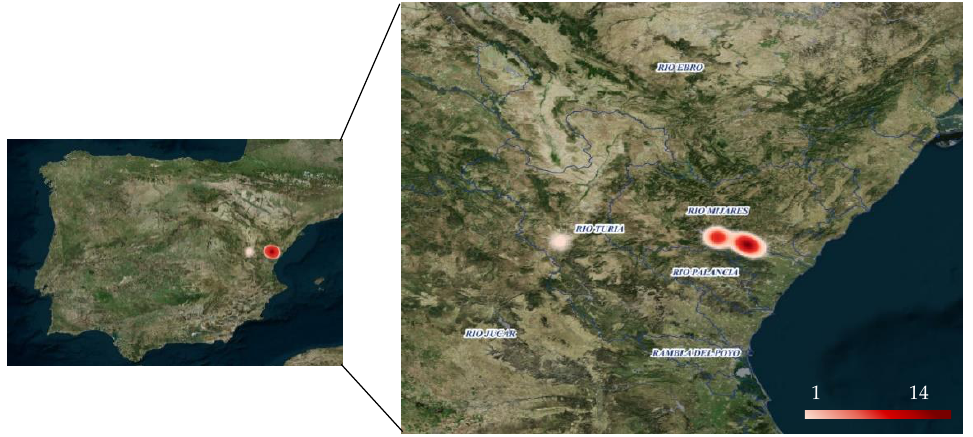
Figure 1. Geographic area where the animals were captured. The color intensity indicates the number of animals captured in each area (see bar on bottom).